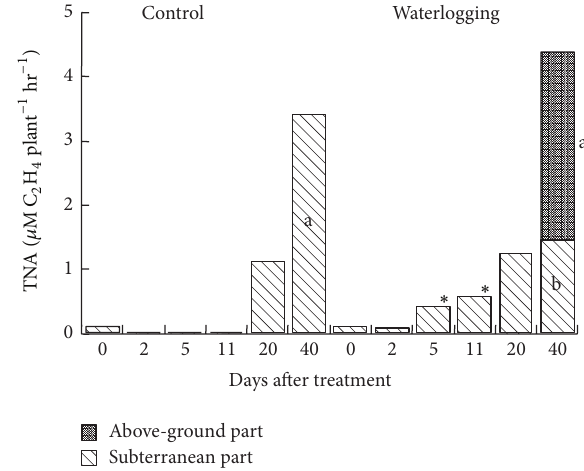
Figure 8: Changes in total nitrogenase activity (TNA) in experiment 2. Symbols with different letters within the same investigation date and treatment show significant differences ( 𝑃 < 0.05 ). ∗ Significant difference ( 𝑃 < 0.05 ) in the total TNA at the same day.